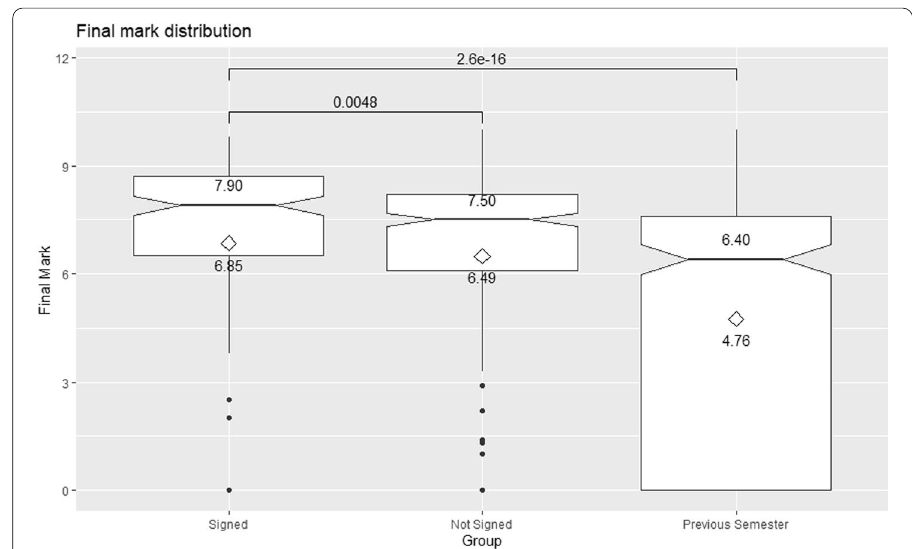
Fig. 5 Notched box‑and‑whisker plot of the final mark distribution with the corresponding p‑value of the unpaired two‑sample Wilcoxon test, median and mean (diamond sign) values for each group for Introduction to enterprise course